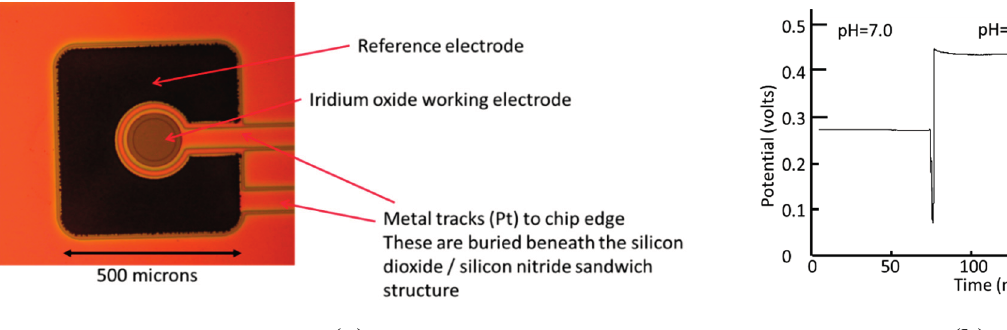
Figure 3. pH sensor: ( a ) Photograph of microfabricated iridium oxide (IrOx) sensor ( b ) Potential-time response following substitution of different value pH buffer